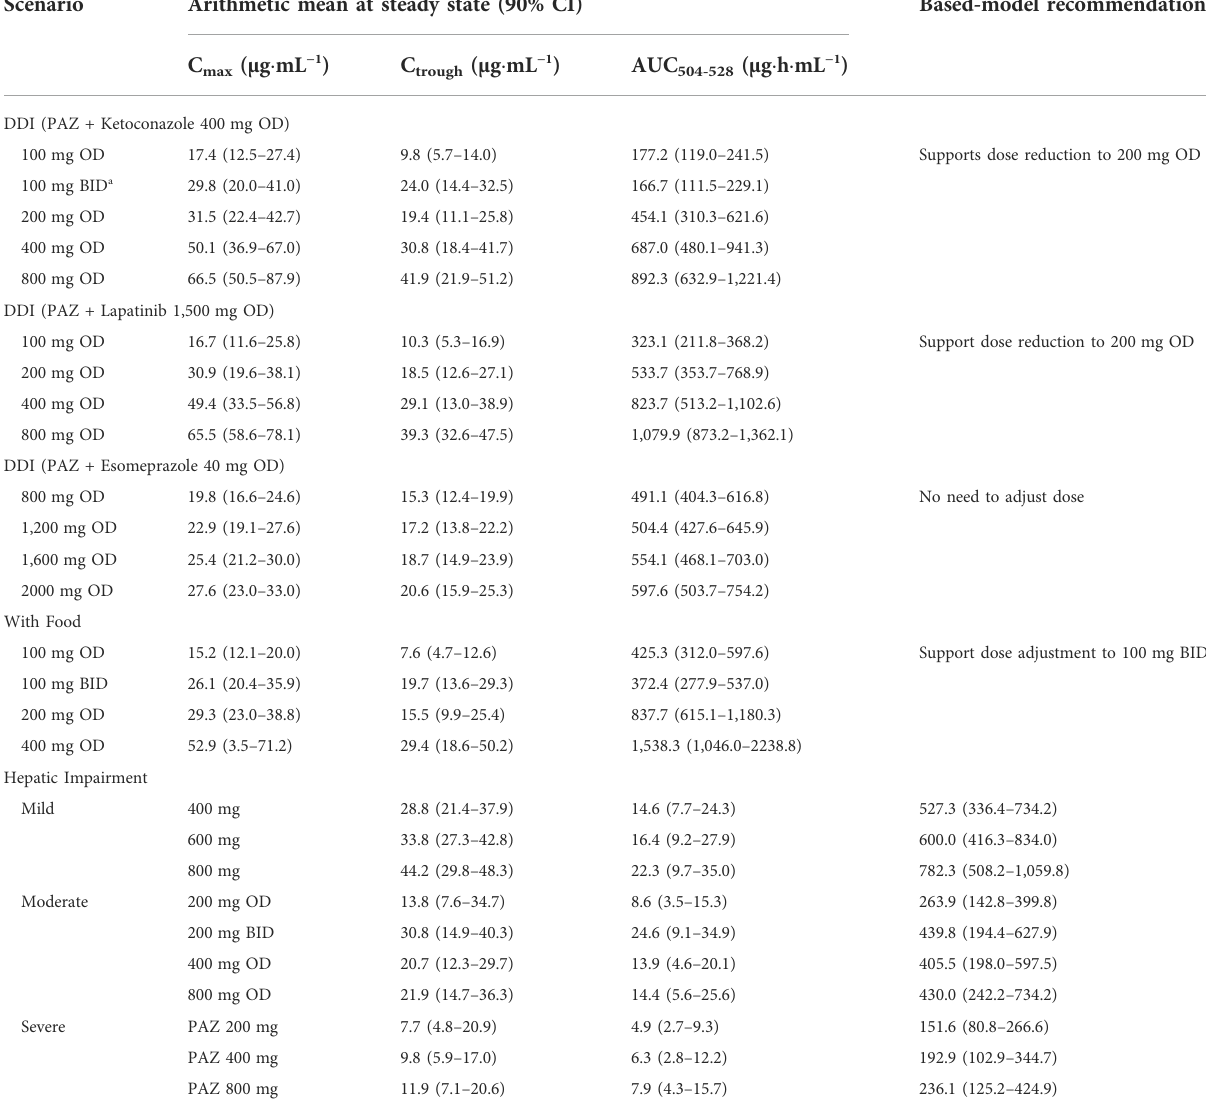
TABLE 8 PAZ dosing adjustment recommendation based on the PBPK